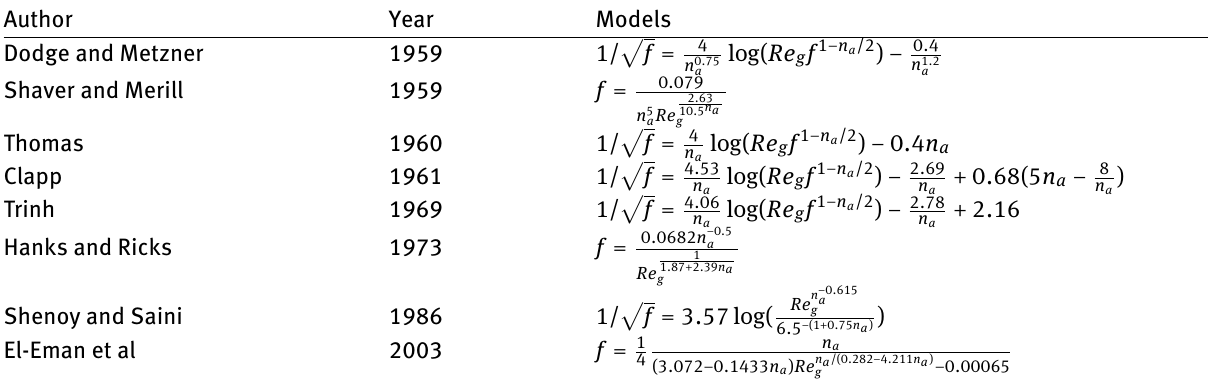
Table A1: Friction factor correlations for Non-Newtonian fluids in turbulent flow